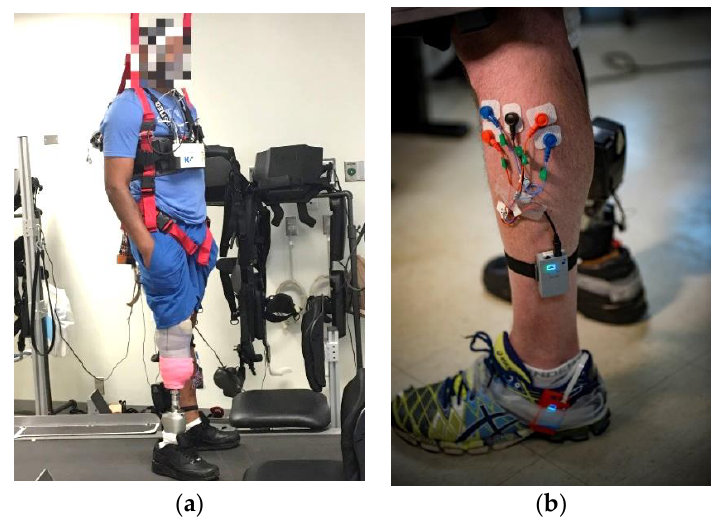
Figure 1. Data collection setup using a body weight supported treadmill system to prevent fall. ( a ) Amputee subject on the treadmill with a protective harness on ( b ) electrode placement on Tibialis Anterior (TA) and Gastrocnemius Lateralis (GL) muscles on the intact limb.